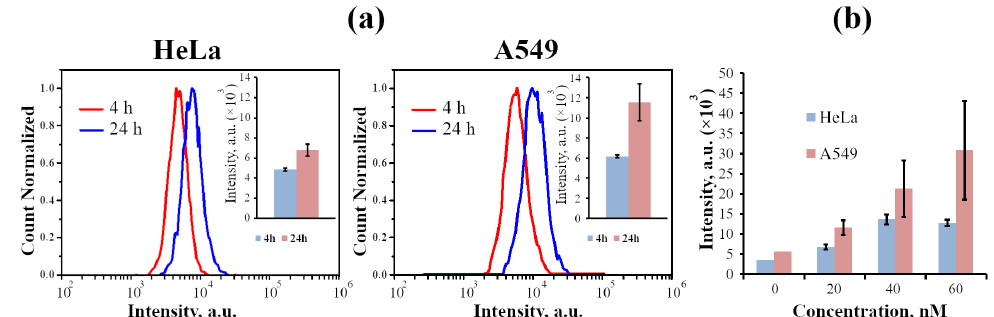
Figure 5. Fluorescence-activated cell sorting analysis of InP-QD uptake by cells. ( a ): Distributions of the fluorescence intensity of the cell population after the incubation of cells with InP-QDs (20 nM) for 4 and 24 h. In the upper right corner, the histograms of the average value of a cell fluorescence intensity after 4 and 24 h of incubation with InP-QDs for HeLa and A549 cells, respectively, are presented. ( b ): Accumulation of InP-QDs depending on the concentration (20, 40, and 60 nM) after 24 h of incubation of cells with InP-QDs. The fluorescence intensity of the control cells without InP-QDs (0 nM) indicates the autofluorescence of the